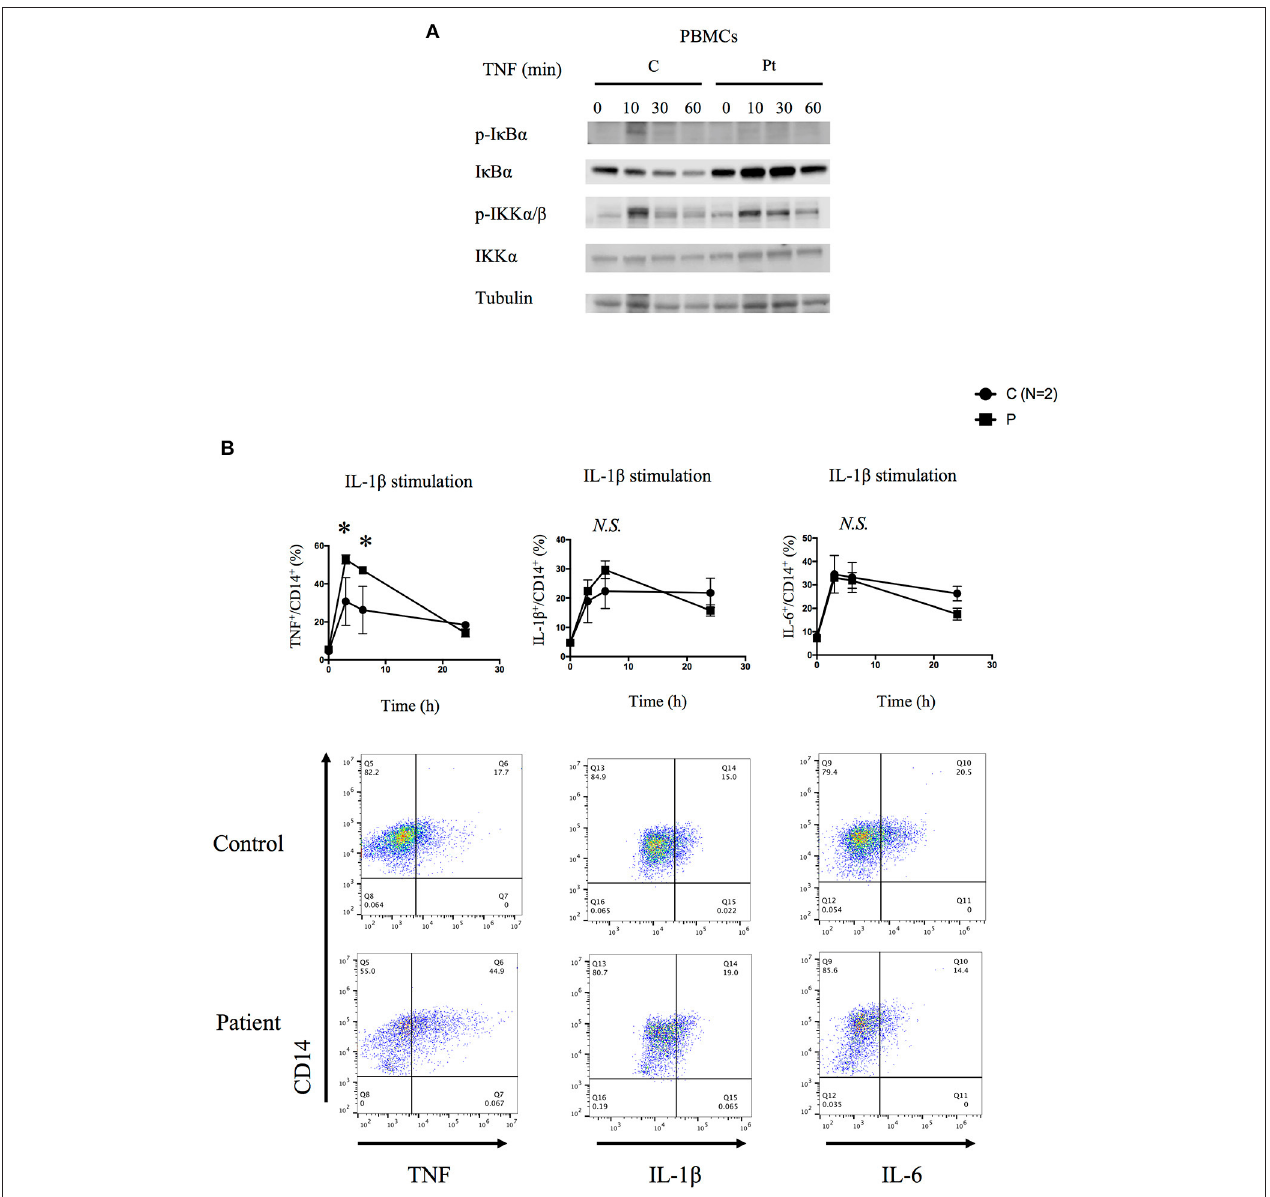
FIGURE 3 | Molecular consequences of the HOIP deficiency. (A) PBMCs from the HOIP deficient patient showed decreased levels of phosphorylated I κ B α and delayed phosphorylation of IKK α / β after TNF stimulation (20ng/ml) compared with an unrelated healthy control. (B) Cytokine responsiveness of CD14 + monocyte subsets in the HOIP deficient patient and unrelated healthy controls ( N = 2). Representative FACS plots are shown. Analysis was performed in triplicates. Two-way factorial ANOVA with Bonferroni adjustment was performed for the statistical analysis. *adjusted p <